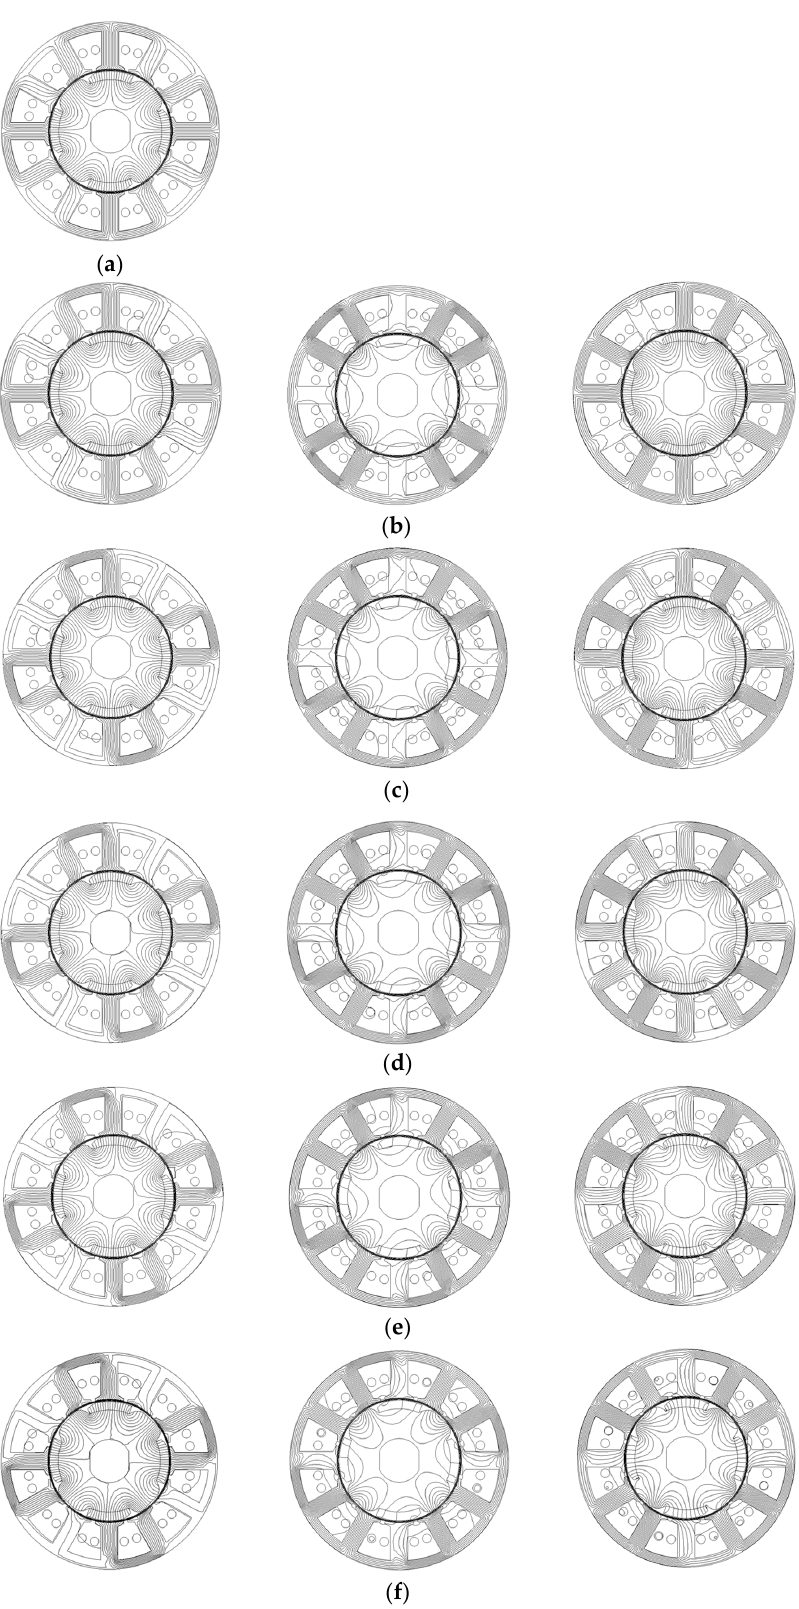
Figure 27. Equal potential distributions for 12s8p-PSCPPM. (from left to right: PM only, armature current only, overall) ( a ) 0A. ( b ) 10A ( c ) 20A. ( d ) 30A. ( e ) 40A. ( f ) 50A.